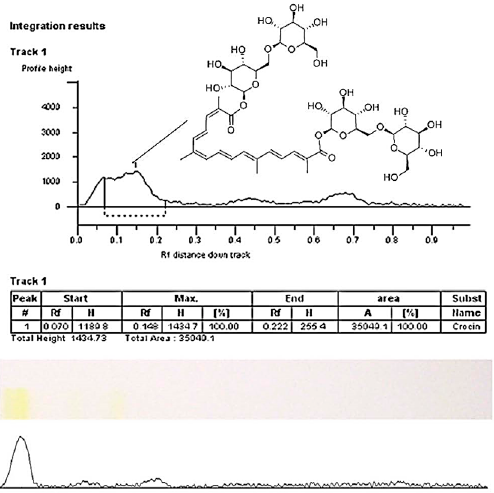
Figure 3. HPTLC chromatogram of crocin reference standard (5 mg/mL) and its chemical structure (peak 1).